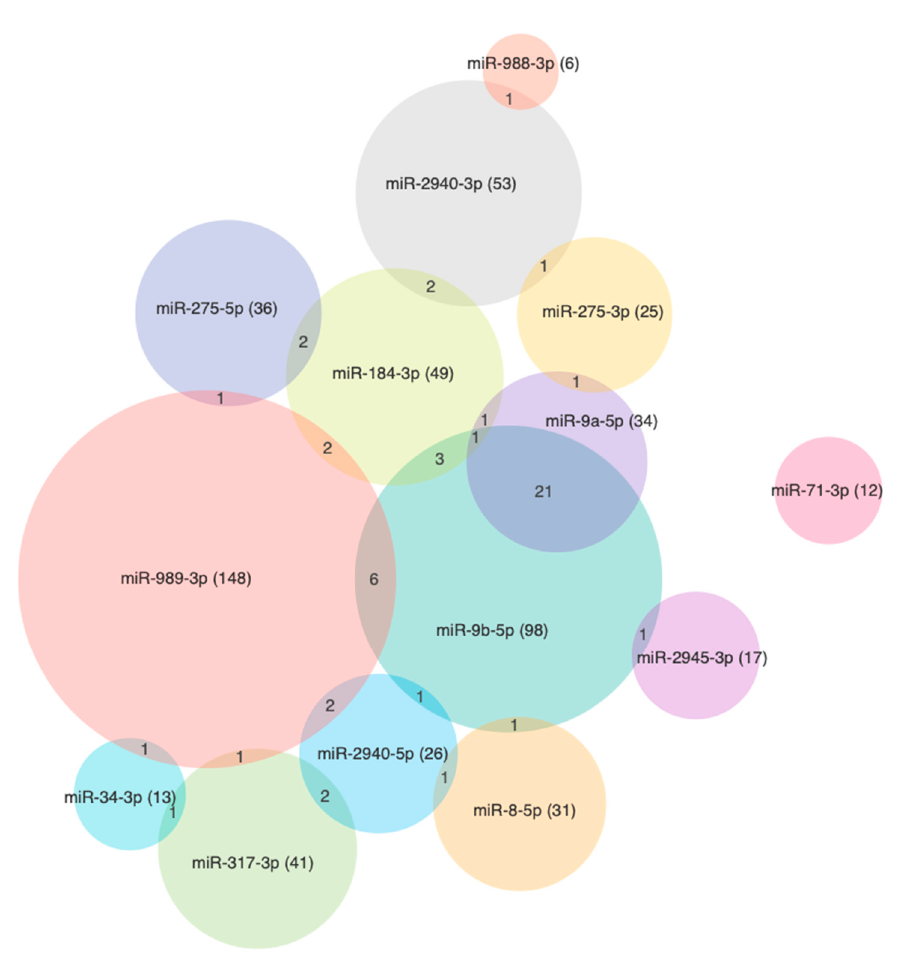
Figure 7. Venn diagram showing the number of predicted targets for each miRNA, wherein the intersect shows the number of predicted targets in common.